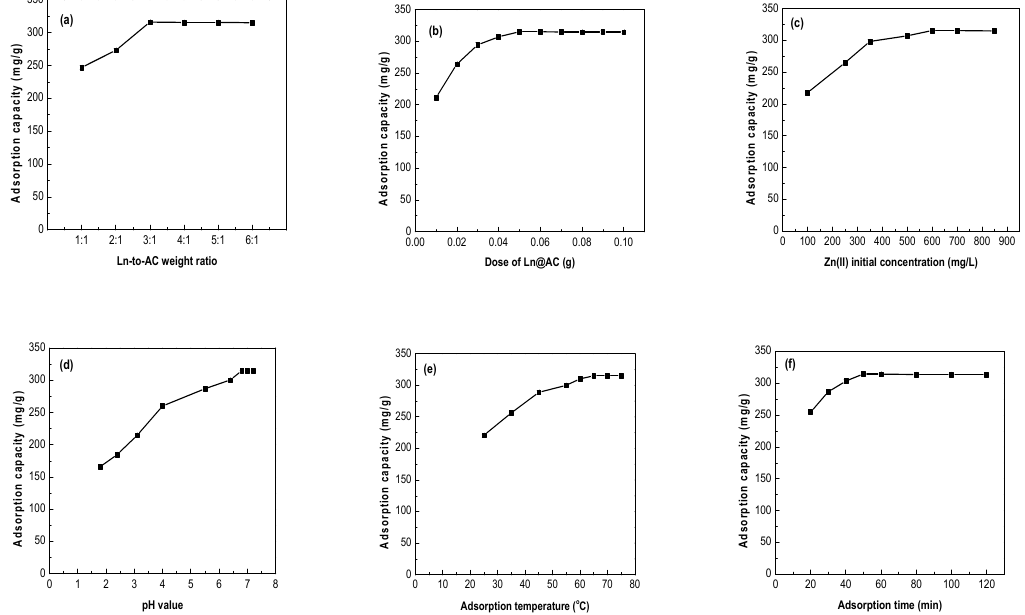
Figure 5. Various influencing factors on Zn(II) adsorption by the Ln@AC nanocomposite. ( a ) Effect of weight ratio of Ln to AC (weight ratio: 1:1–6:1; dosage: 1 g/L; Zn(II) concentration: 600 mg/L; pH: 6.8; temperature: 65 °C; time: 50 min). ( b ) Effect of Ln@AC dosage (weight ratio: 3:1; dosage: 0.01–0.10 g; Zn(II) concentration: 600 mg/L; pH: 6.8; temperature: 65 °C; time: 50 min). ( c ) Effect of Zn(II)